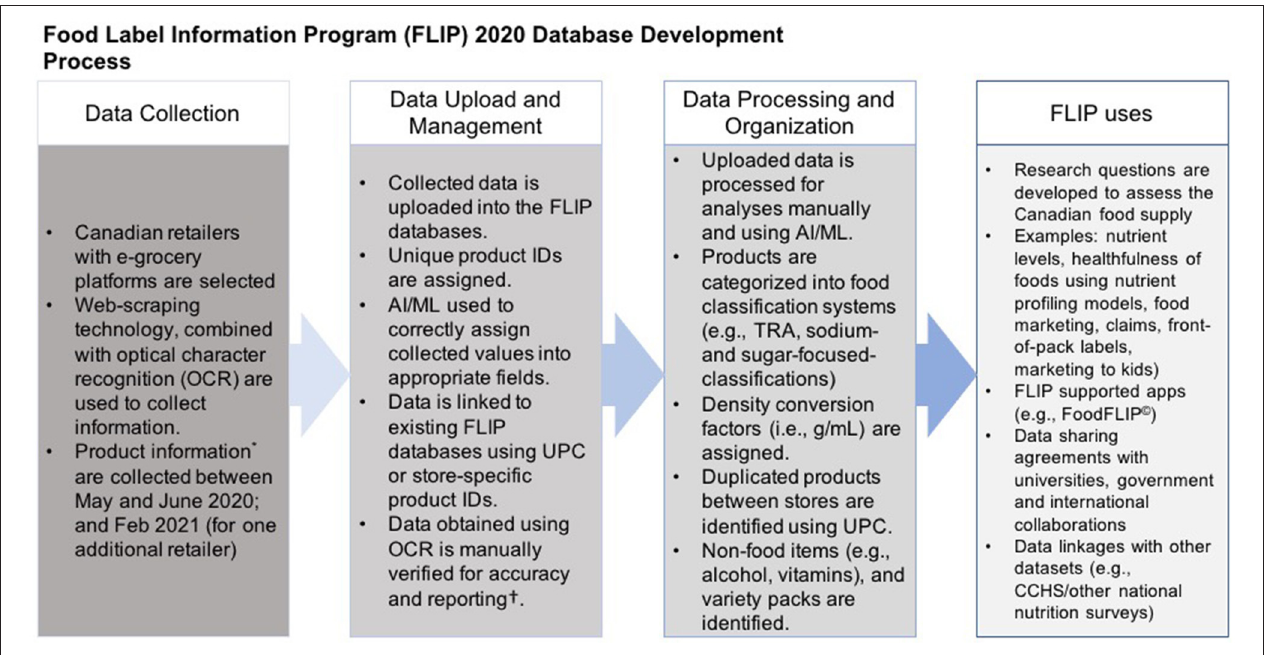
FIGURE 1 | Phases of development of Food Label Information Program (FLIP) 2020. FLIP 2010, 2013, and 2017 are previous versions of FLIP.